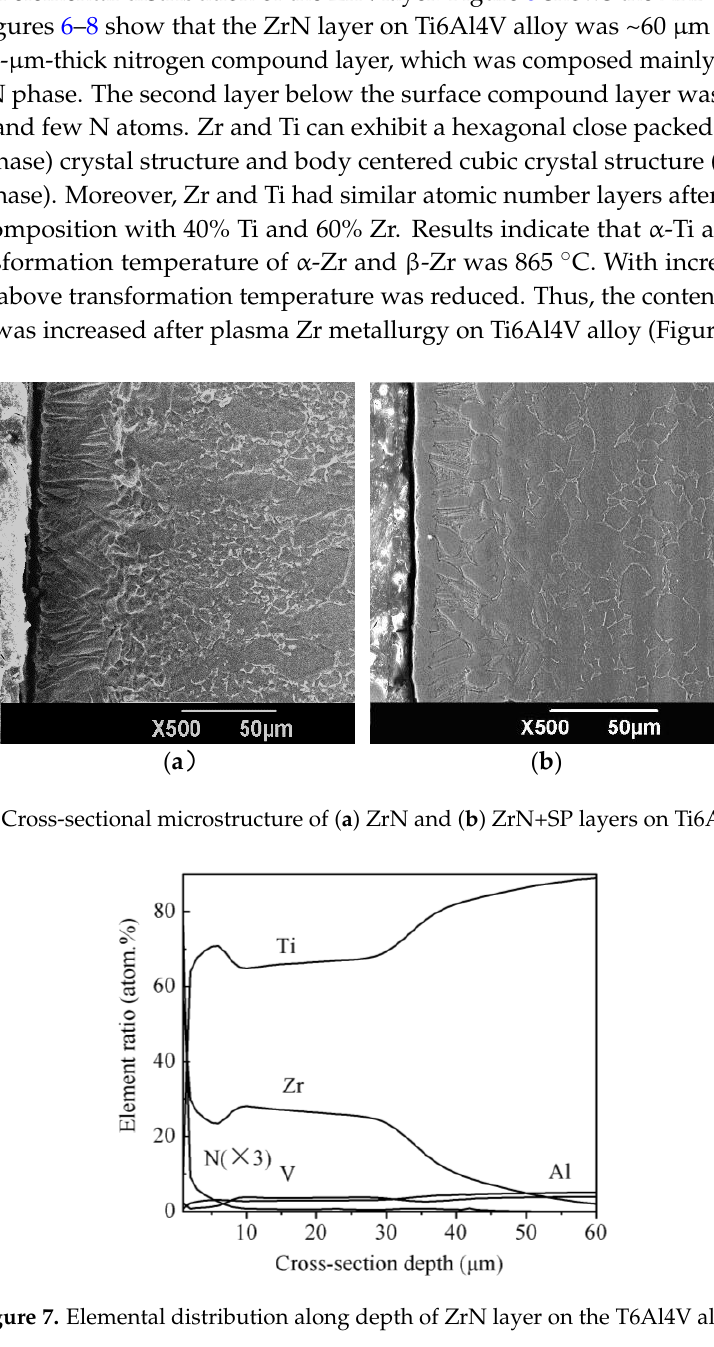
Figure 8. XRD results of the ZrN and ZrN+SP layers. Figure 9. XRD results of plasma Zr alloying specimen. 3.2. Cross-Sectional Microhardness Distribution Figure 10 shows the cross-sectional microhardness distribution of the ZrN layer. The surface microhardness of the ZrN layer was 1775 HK 0.1 and 1930 HK 0.1 after post shot peening, which were both greater than that of Ti6Al4V base (420 HK 0.1 ). The microhardness along the depth of both metallurgy layers changed gradually. The gradient change of microhardness with depth is beneficial for improving the load bearing ability.